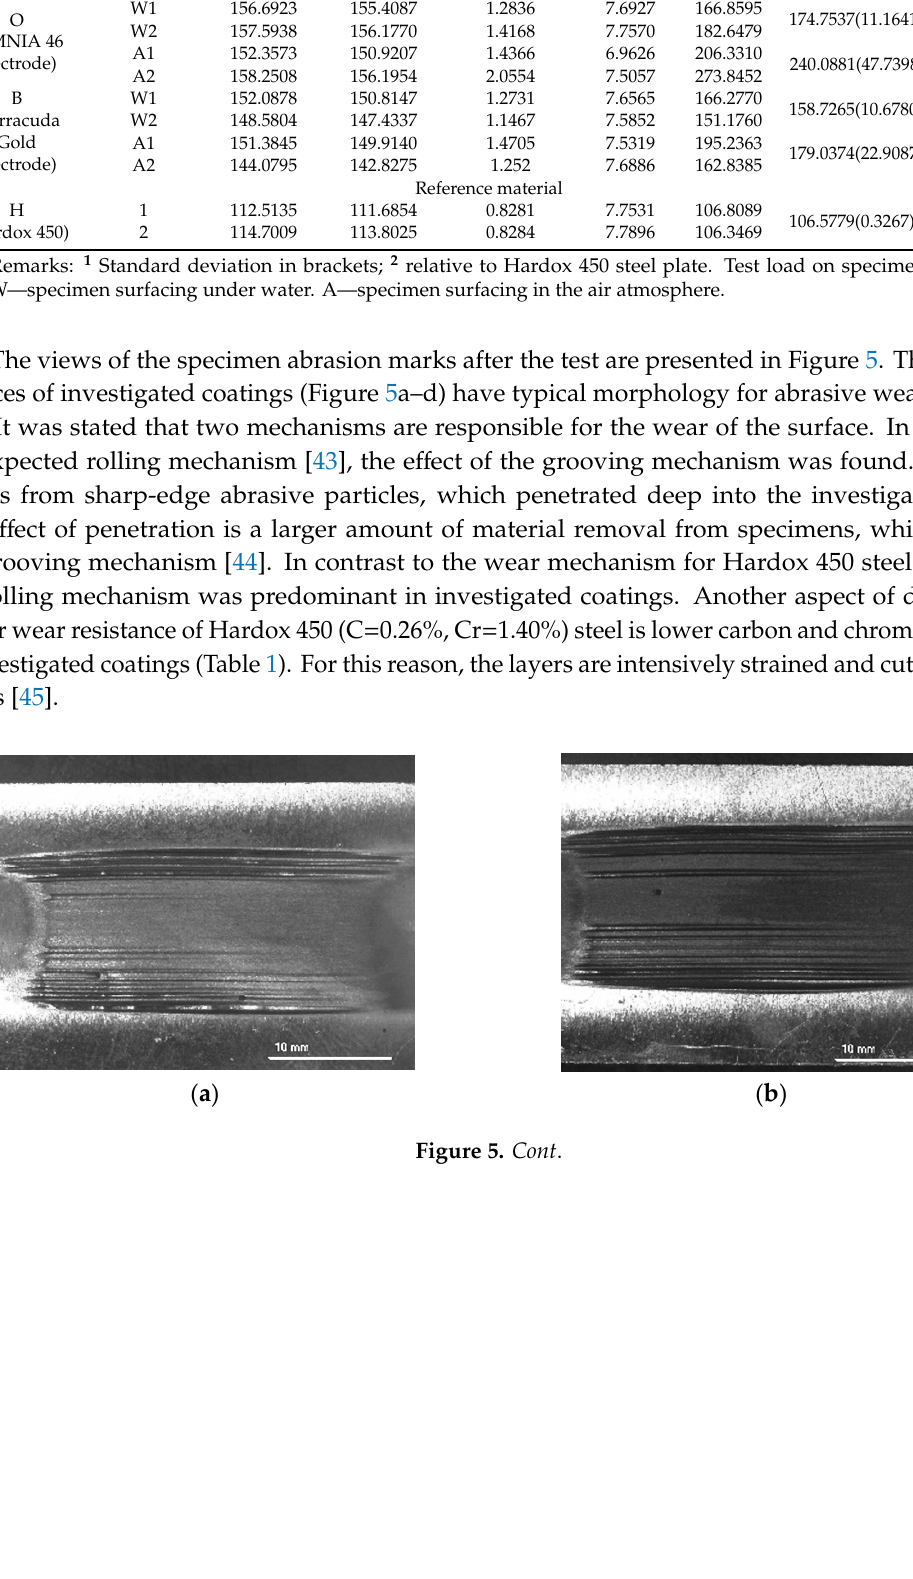
Table 2. Results of abrasive wear resistance